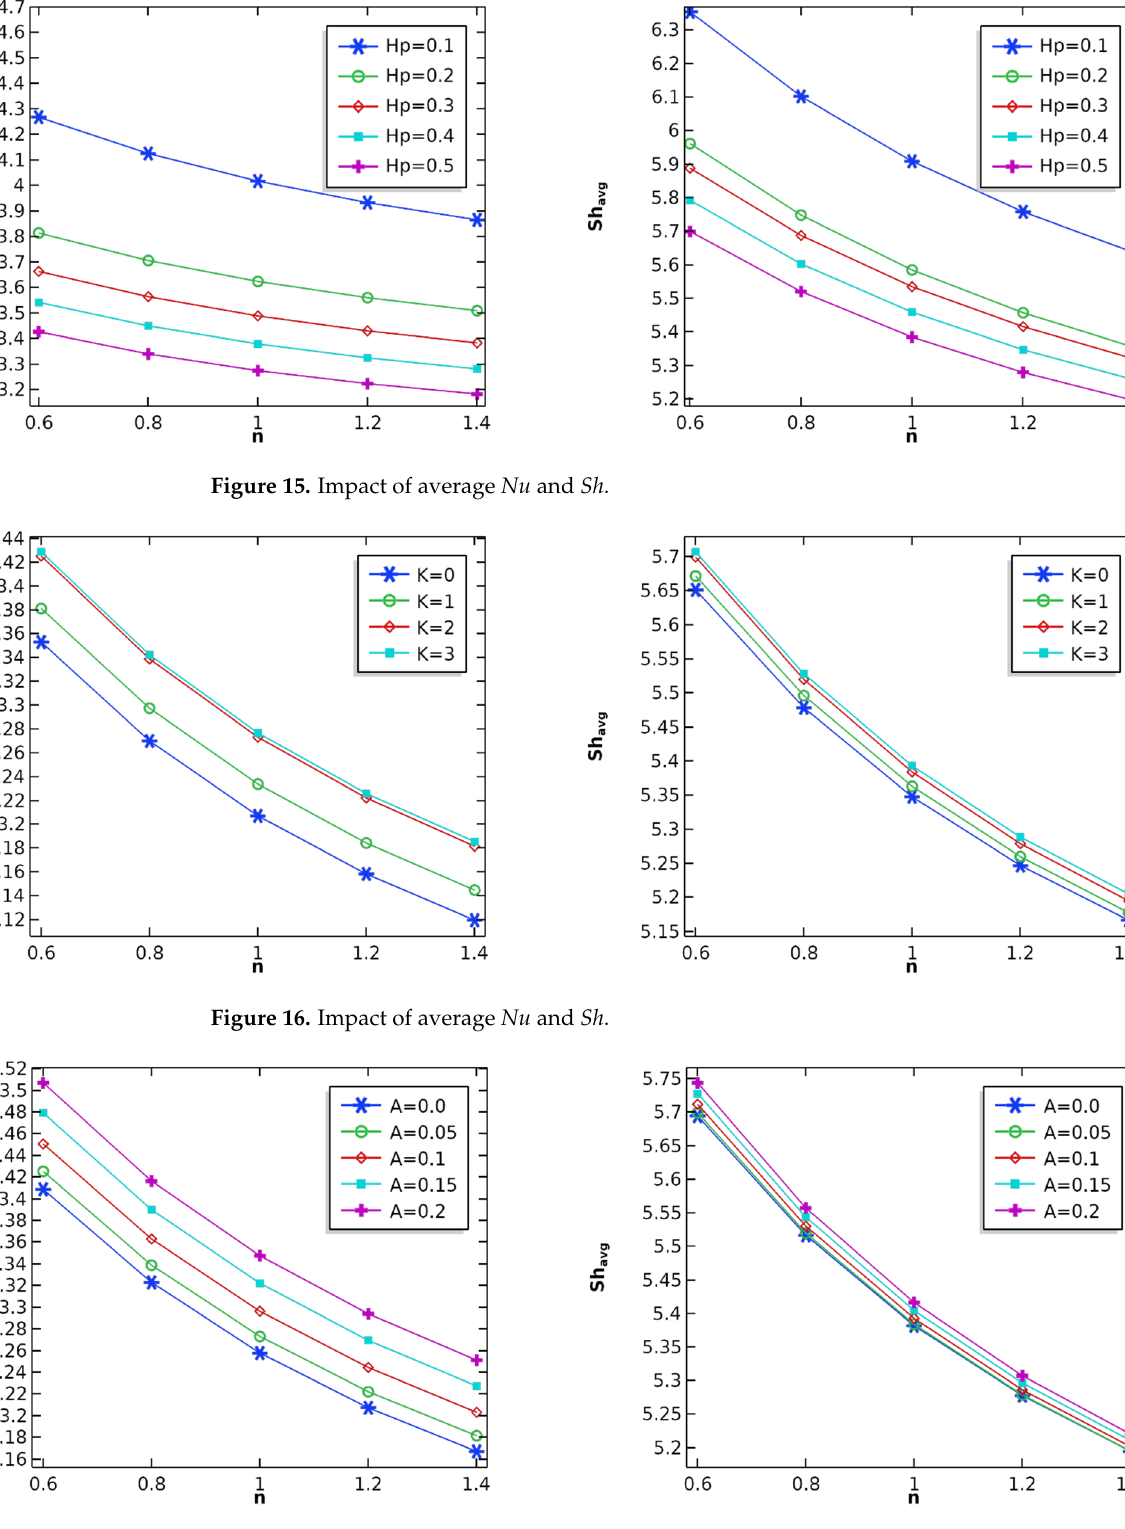
Figure 17. Impact of average Nu and Sh .